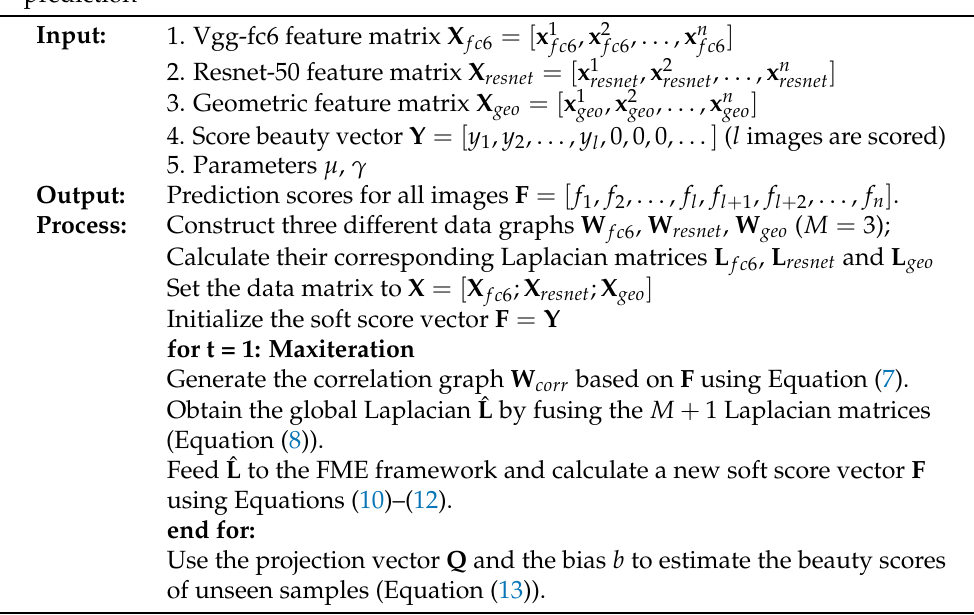
Algorithm 1: Multi similarity metric fusion manifold embedding for face beauty